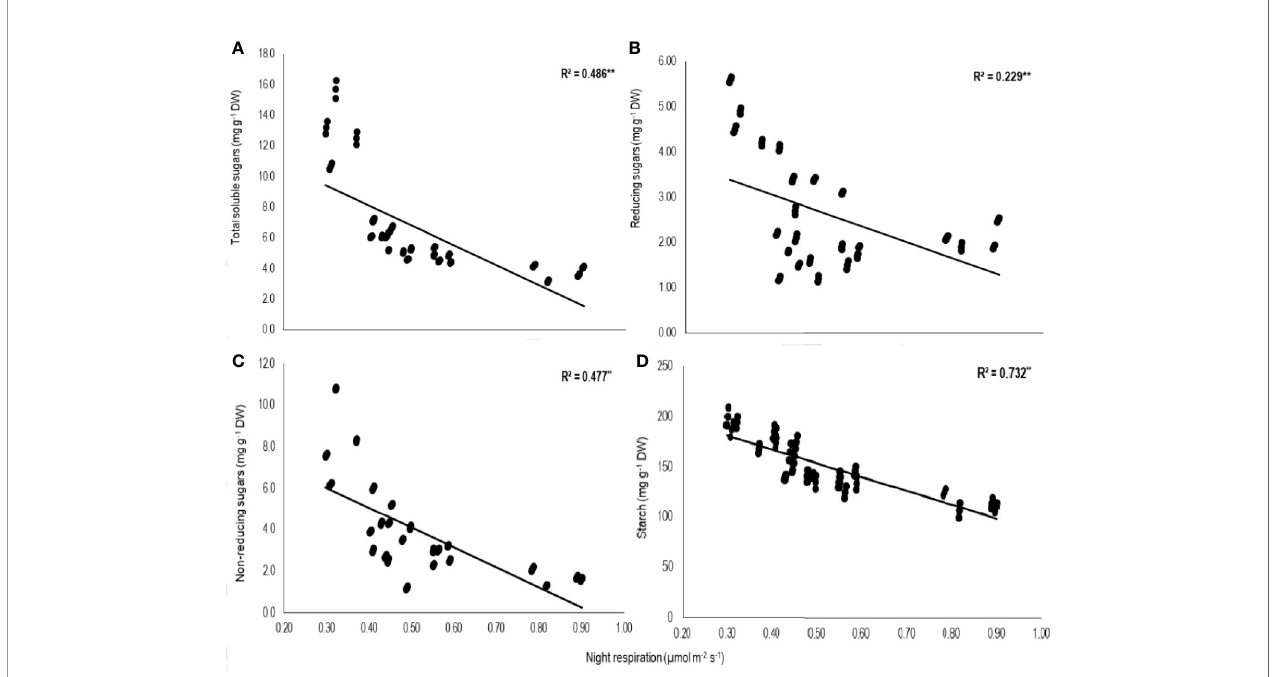
FIGURE 6 | Relationship of night respiration with (A) total soluble sugars (TSS), (B) reducing sugars (RSS), (C) non-reducing sugars (NRS), and (D) starch of two sorghum hybrids (DK 53 and DK 28E) exposed to two mean temperatures (27 and 35°C) [27°C (optimum mean daytime and nighttime temperature; ODNT) and 35°C (high mean daytime and nighttime temperature; HDNT)] with three diurnal temperature amplitudes (2, 10, and 18°C). Coef fi cient of determination (R 2 ) followed by ** signi fi cant at P < 0.01. respectively. Dry weight (DW).